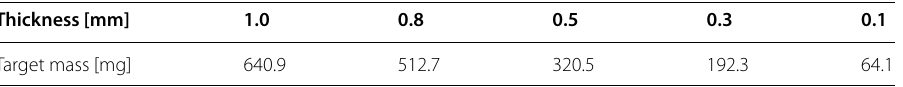
Table 4 The target thicknesses and the corresponding TeO 2 masses Thickness [mm] 1.0 0.8 Target mass [mg]